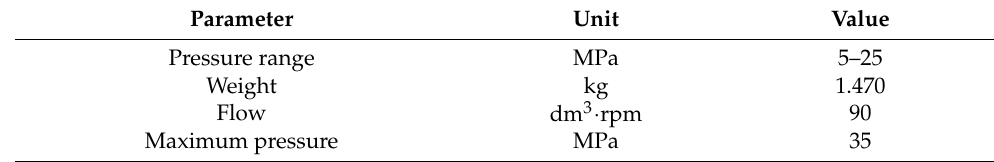
Table 6. Technical parameters of the pressure valve VMP 3/4 (PV 1 , PV 2 ).